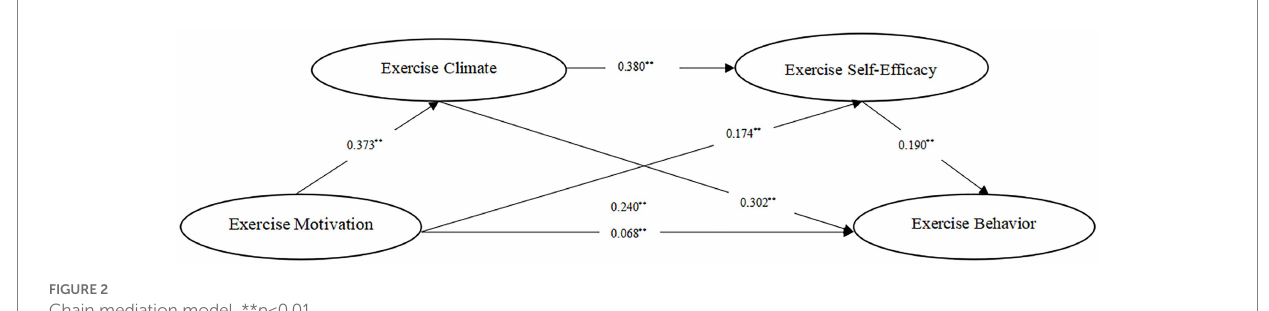
FIGURE 2 Chain mediation model. ** p <